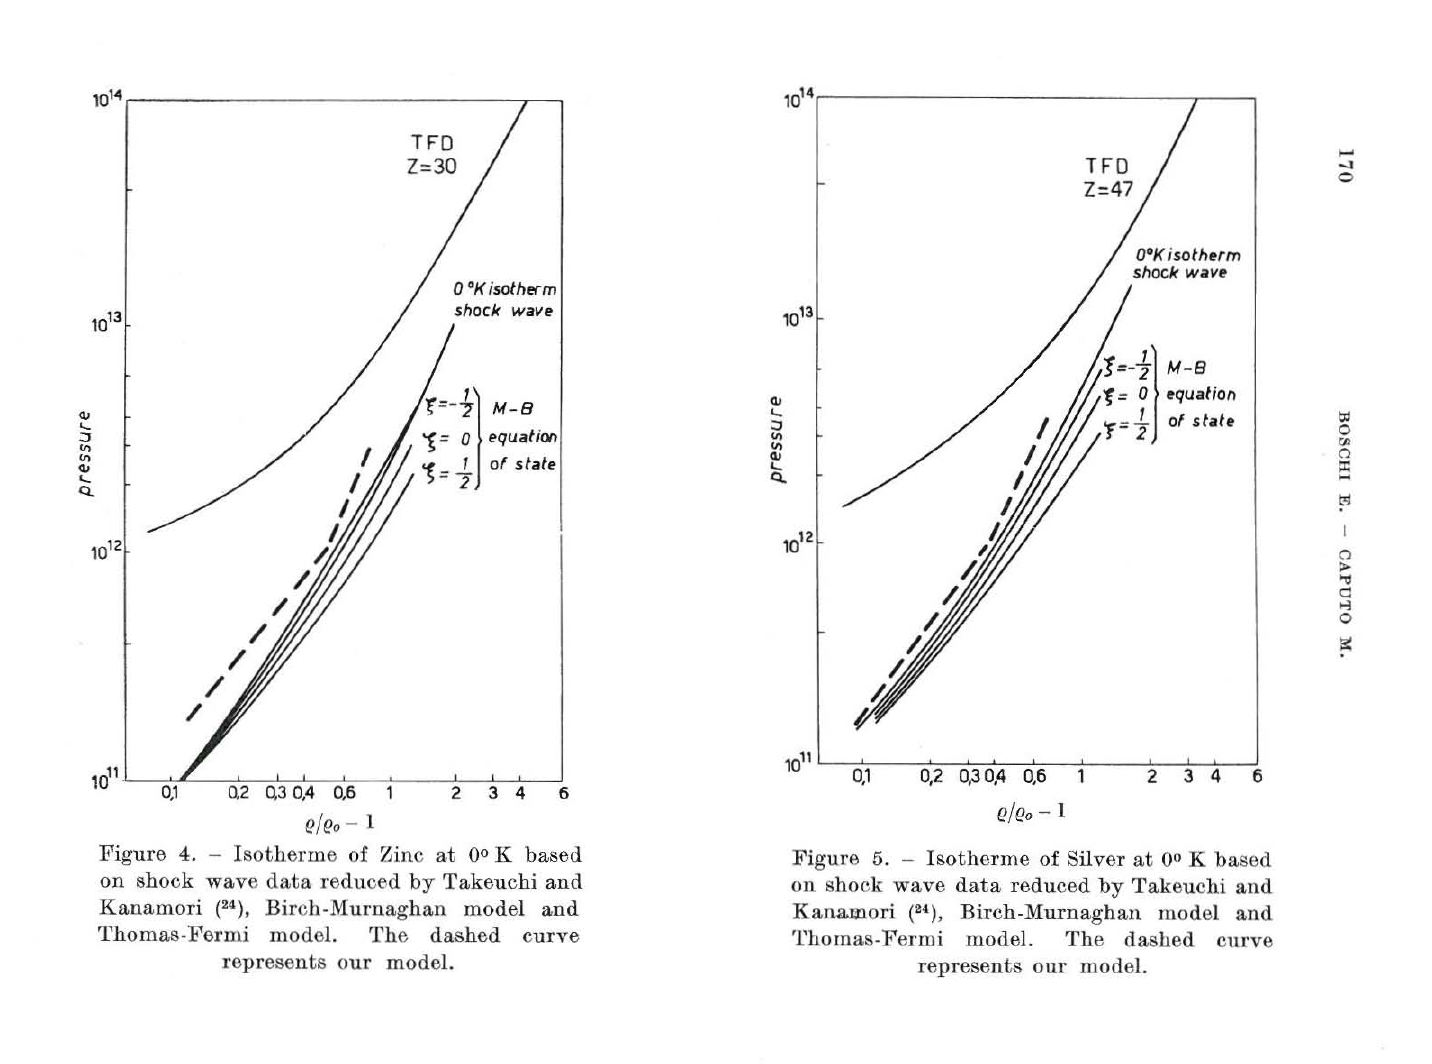
Figure 4. - Isotherme of Zinc at 0° K based on shock wave data reduced by Takeuchi and Kanamori (2<1), Birch-Murnaghan model and l'homas·Fermi mode!. The dashed curve represents our modeI.